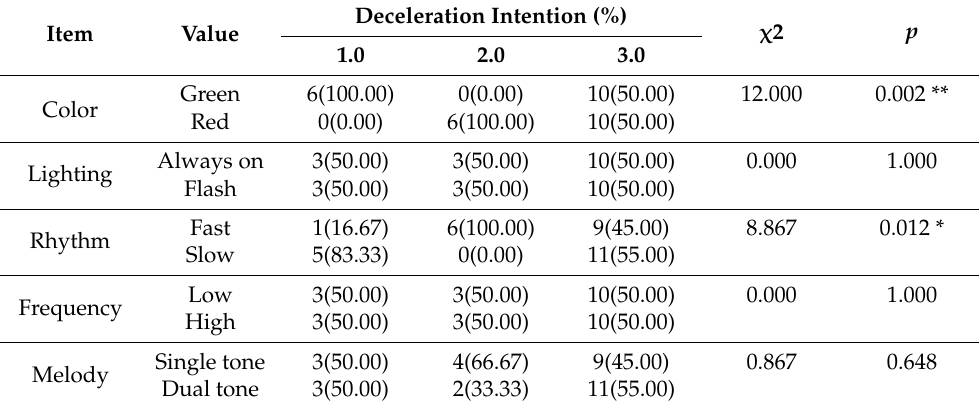
Table 4. Statistical results of Pearson chi-square test in deceleration